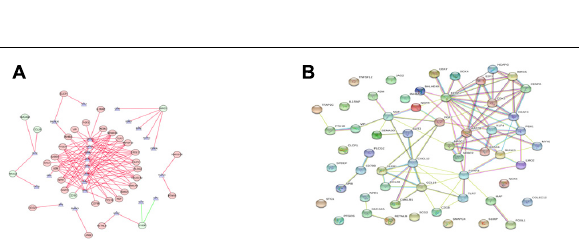
FIGURE 2 | Screening of IRGs related to significant prognosis in CRC. Forest plot showing the prognostic immune-related genes, P values, and hazard ratios. Green dots represent low risk factors, and red dots represent high risk factors.